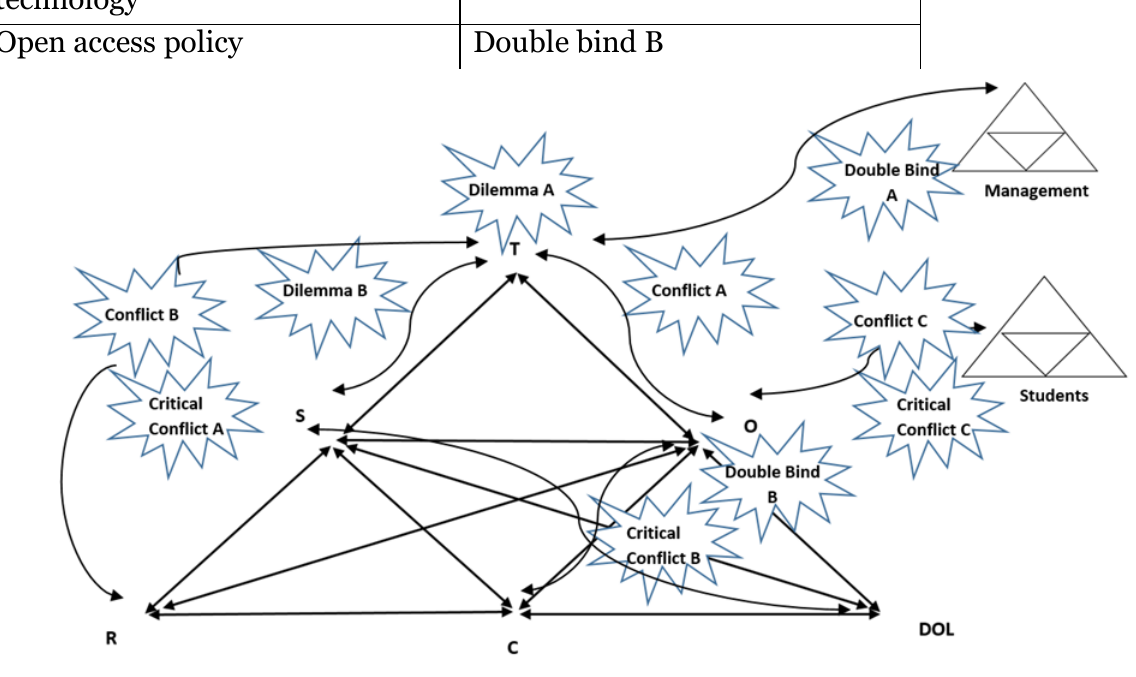
Figure 10: Contradictions mapped to the activity